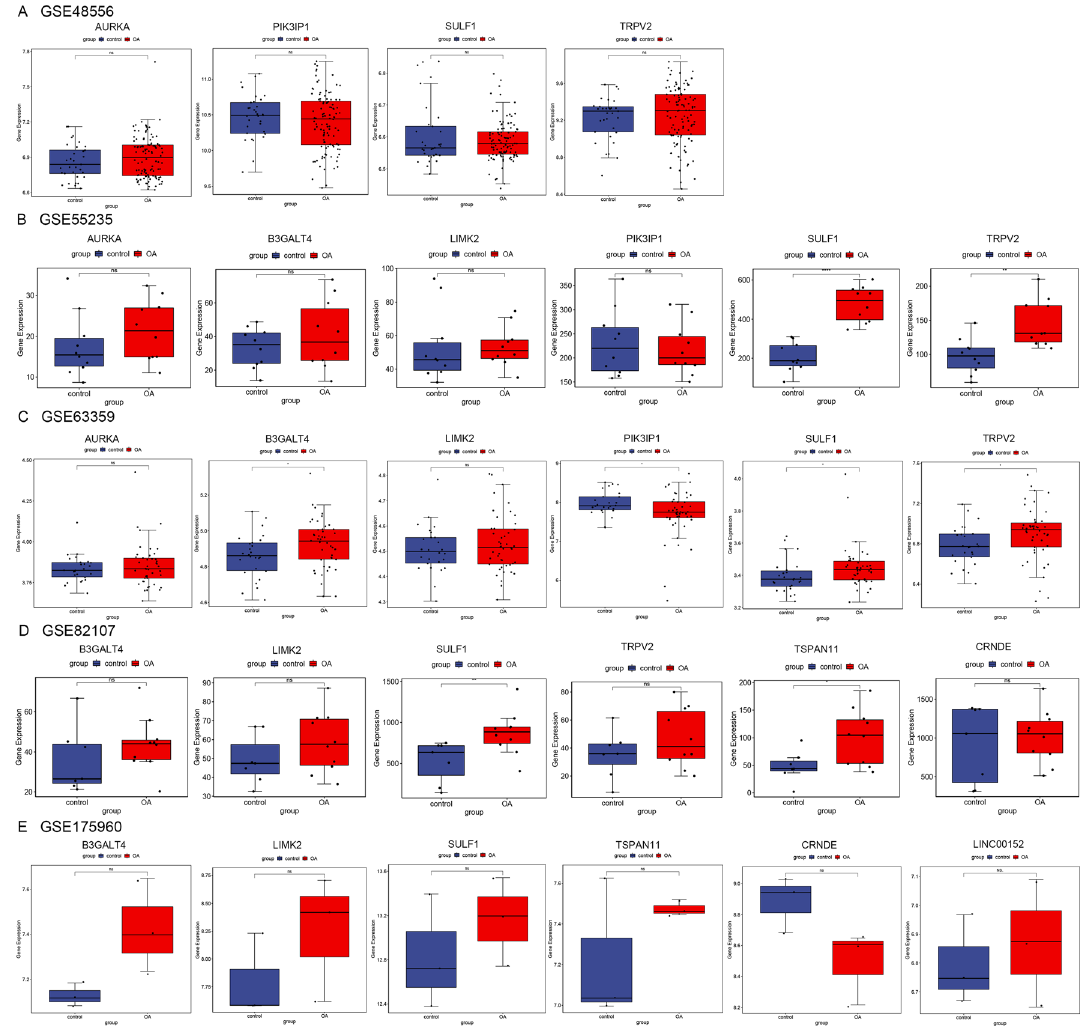
Fig. 5 Expression validations of DEmRNAs and DElncRNAs in GSE48556 ( A ), GSE55235 ( B ), GSE63359 ( C ), GSE82107 ( D ) and GSE175960 ( E ) databases. The x-axis shows control and OA and the y-axis shows expression